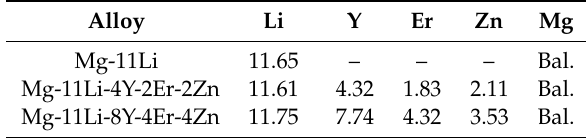
Table 1. Chemical composition of the investigated alloys (wt %).